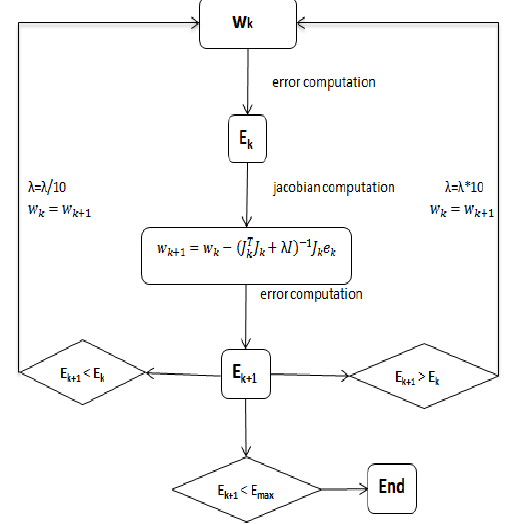
Figure 2. Updating the weight vector through implementaion of Levenberg-Marquardt